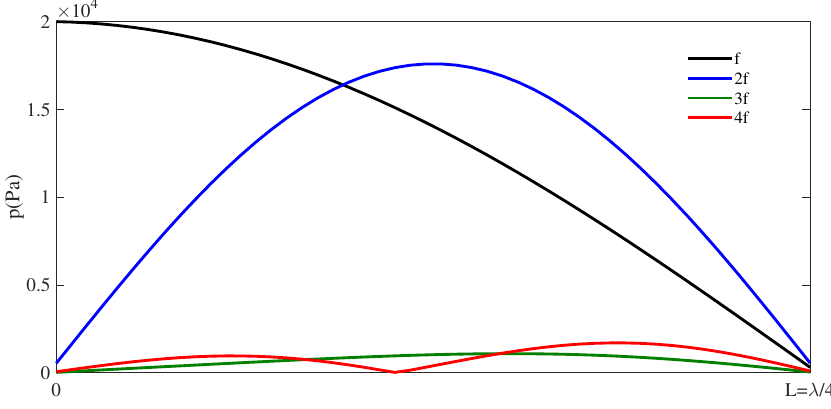
Figure 1. Amplitude of f (black line), 2 f (blue line), 3 f (green line), and 4 f (red line) in the cavity of length L = λ /4 vs. for p s = 20 kPa.